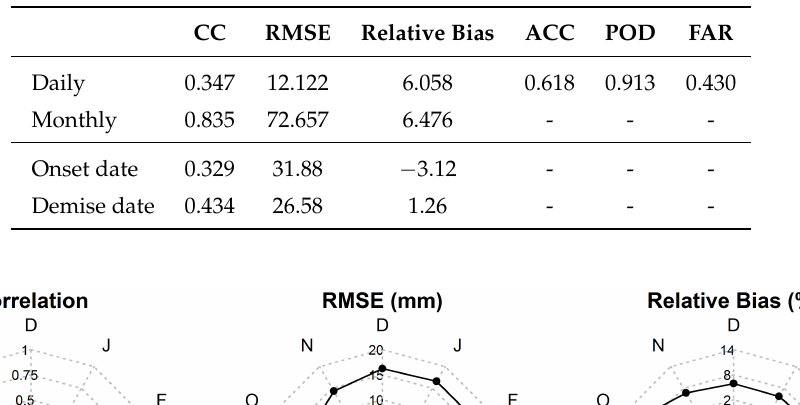
Table 1. Validation results for main statistical indices applied to daily and monthly rainfall values and to onset and demise dates of the rainy season. RMSE: root-mean-square; CC: correlation coefficient; ACC: accuracy; POD: probability of detection; FAR: false alarm ratio.